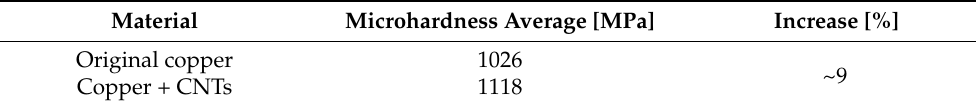
Table 1. Microhardness of the original and modified by copper CNTs.